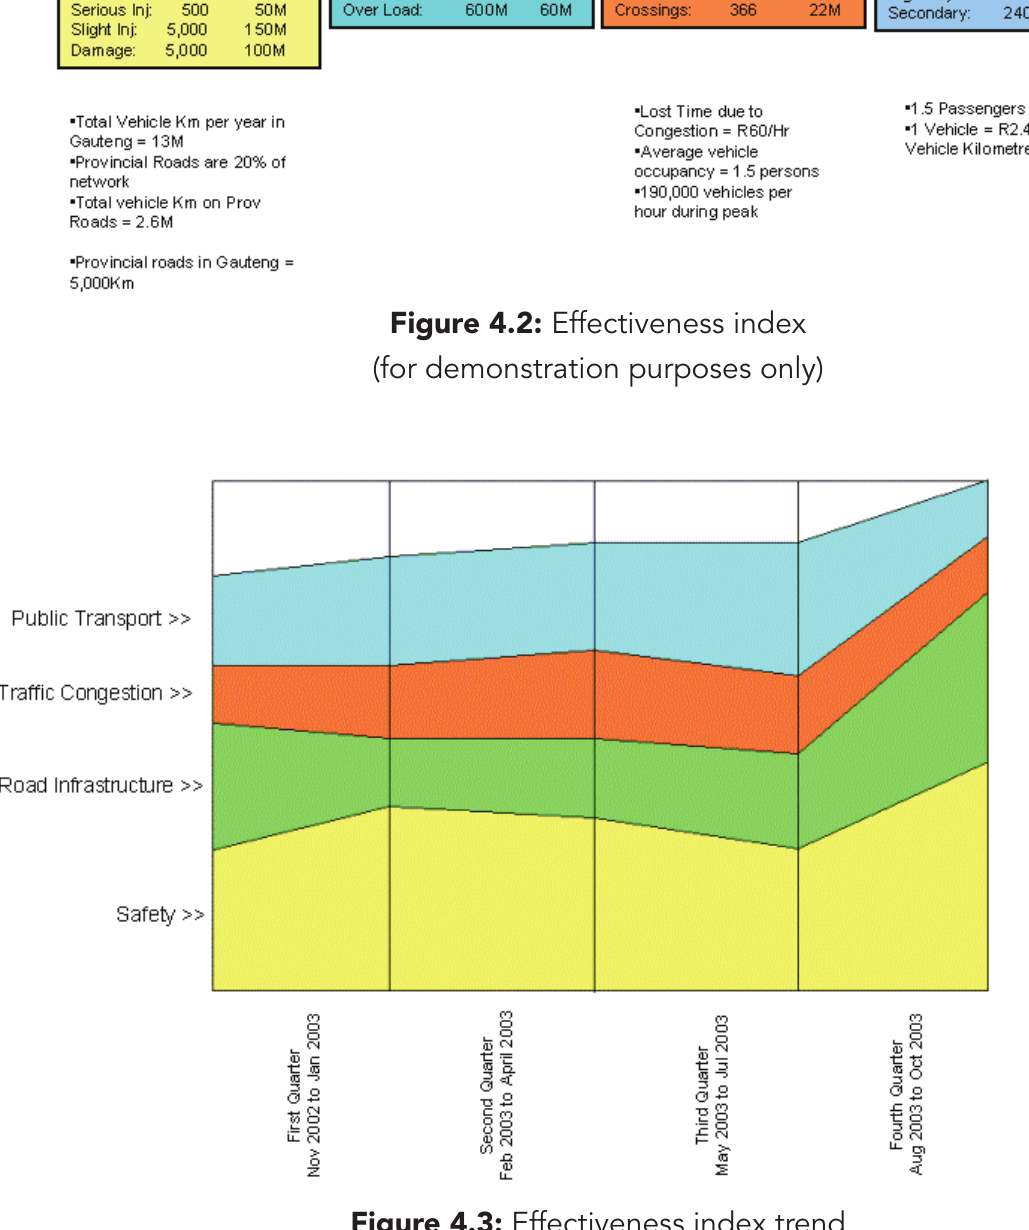
Figure 4.3: Effectiveness index trend Figure 4.3 Page 3: Effectiveness index trend (for demonstration purposes (for demonstration purposes only)